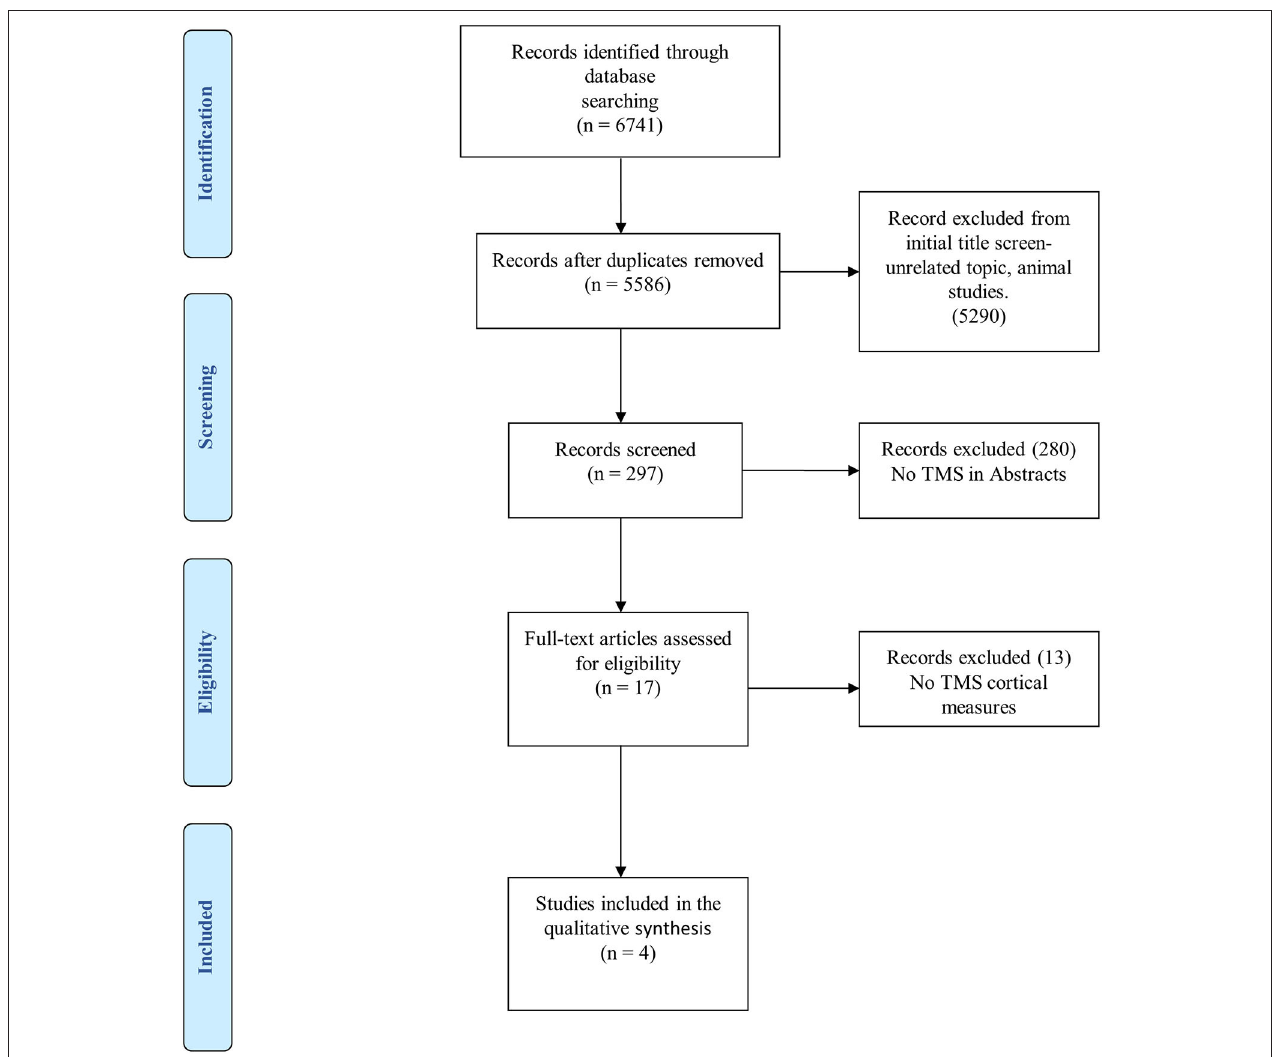
FIGURE 3 | PRISMA flowchart for systematic review and